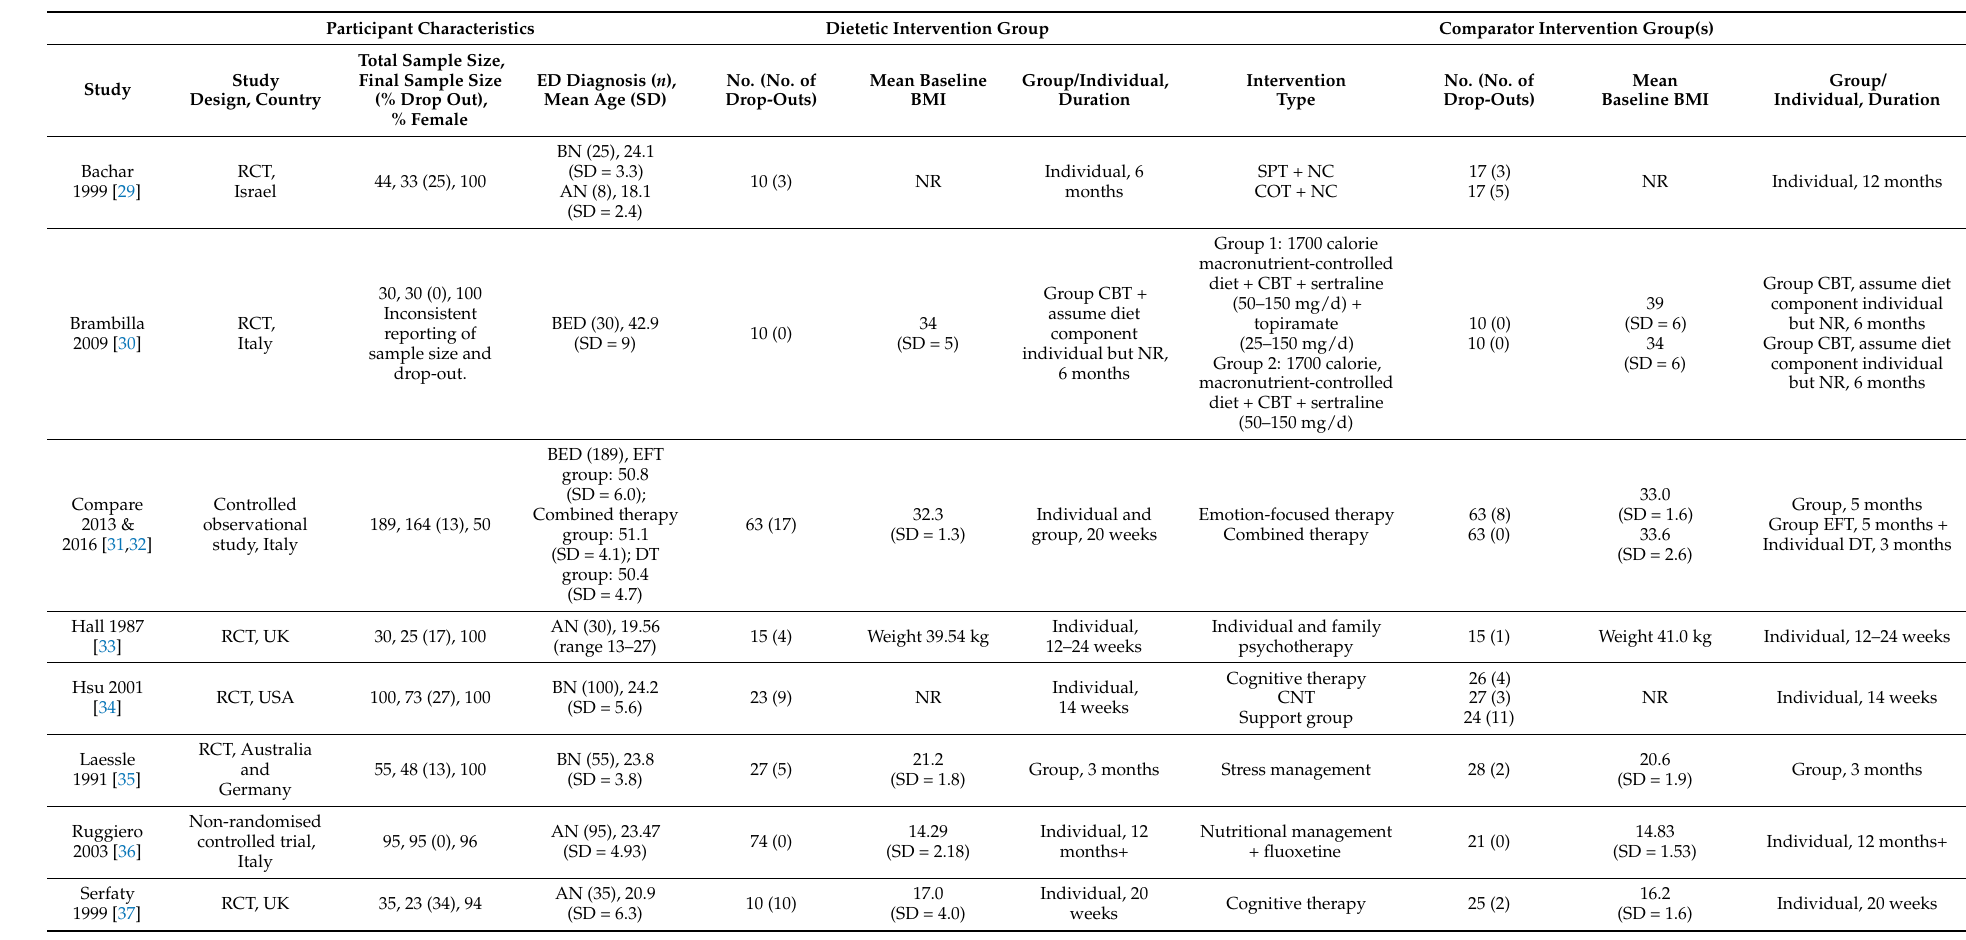
Table 1. Characteristics of included